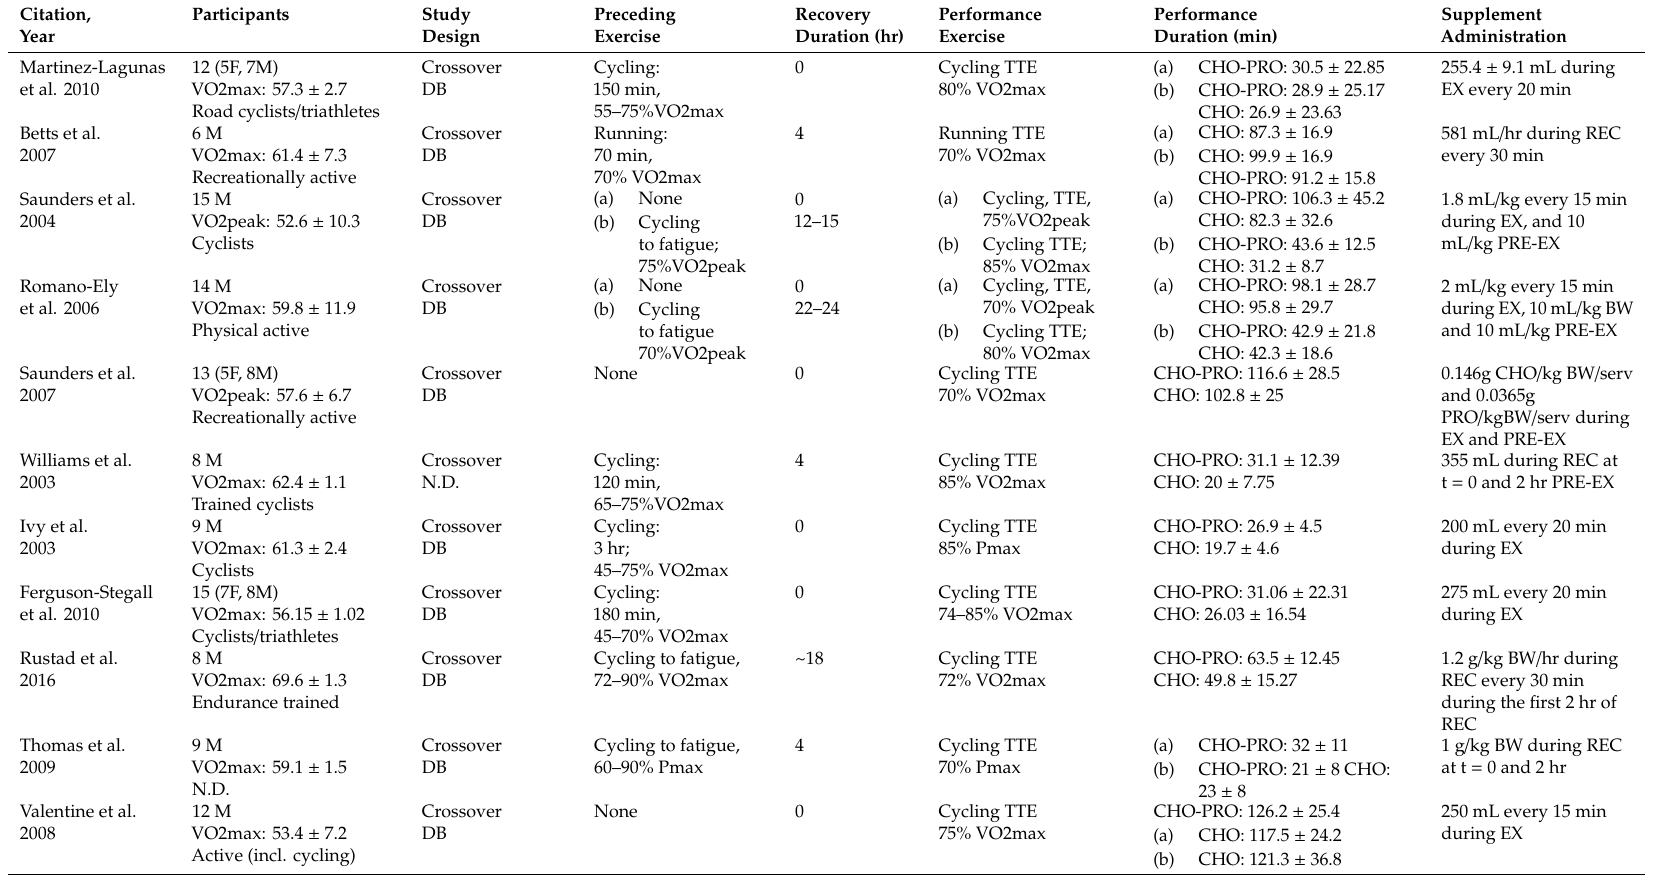
Table 1. Characteristics of included